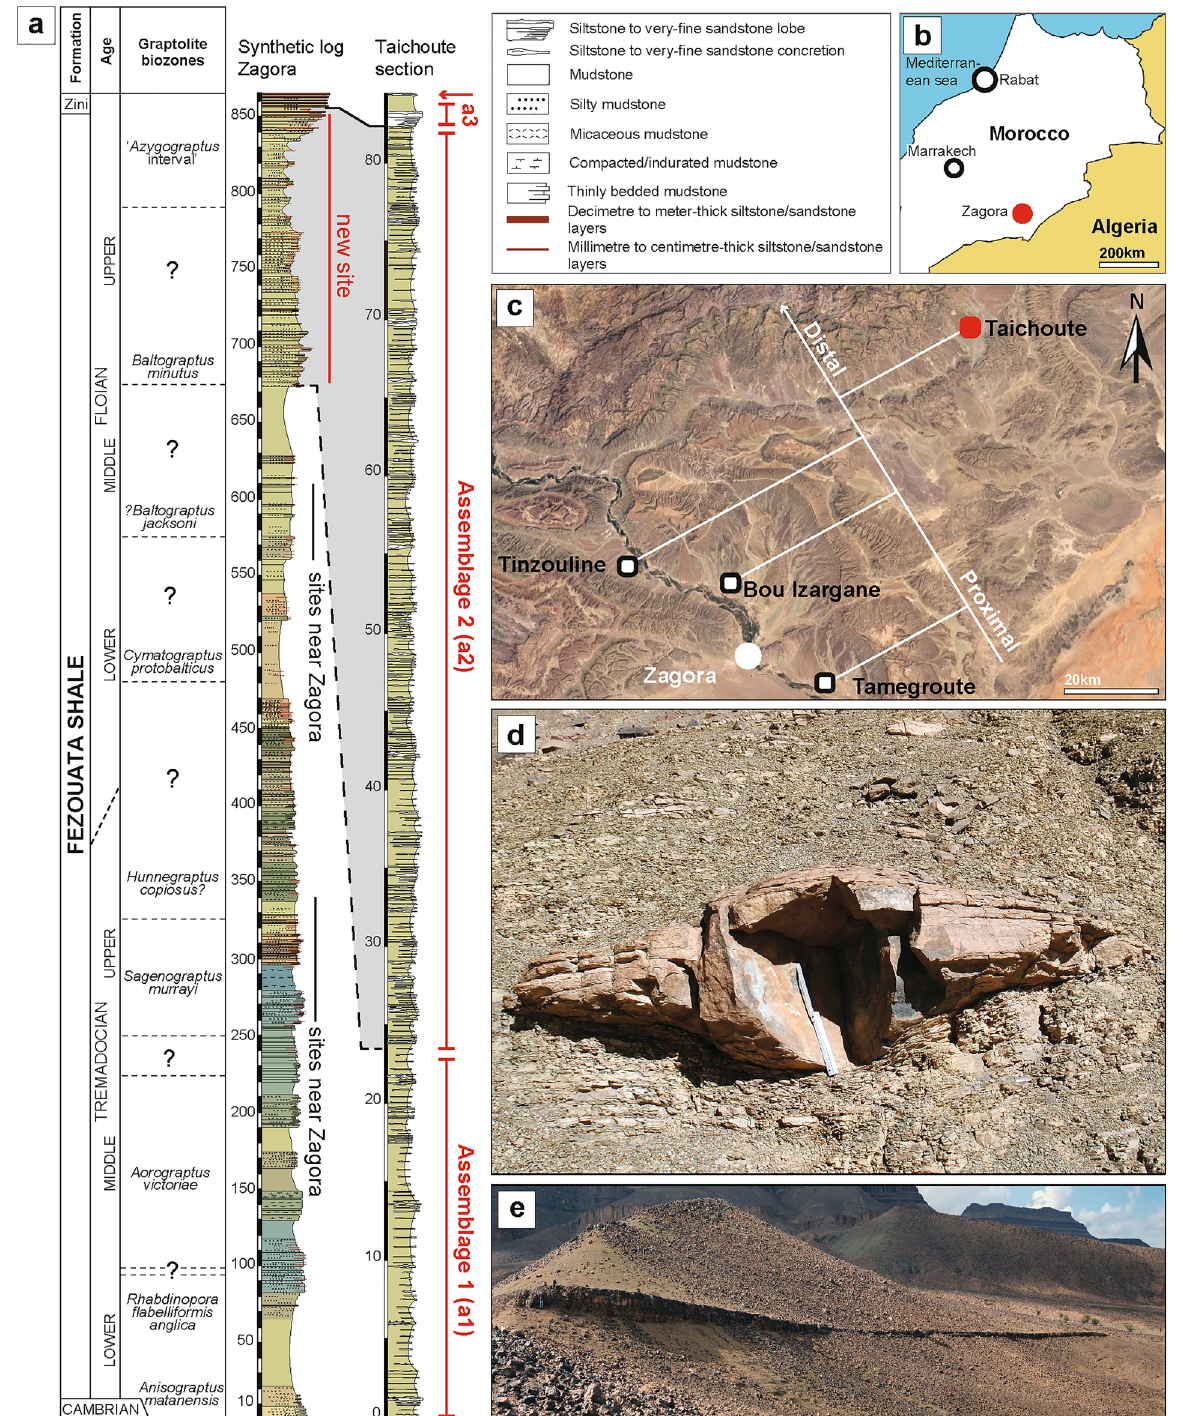
Figure 1. ( a ) Stratigraphic column for the Lower Ordovician Fezouata Shale and Zini formations including the Taichoute locality divided into three fossil assemblages. The red arrow in ( a ) indicates an accumulation level of brachiopods and bryozoans at the top of the Taichoute section. ( b ) Zoom on the Zagora Region where the Fezouata Shale was discovered. ( c ) Taichoute is the most distal site in the depositional environment of the Fezouata Shale. ( d ) Concretion from the Zagora region. ( e ) A large lobe from the Fezouata Shale in the upper part of the succession (a3) and interpreted as a density-flow